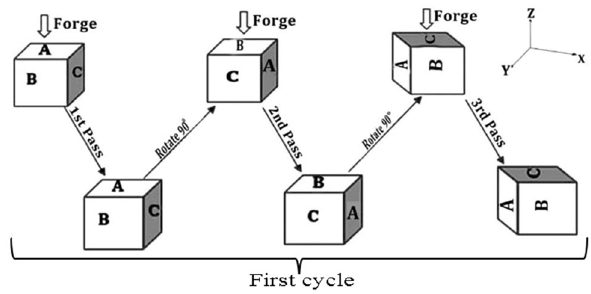
Fig. 1 A general schematic diagram of the MDF